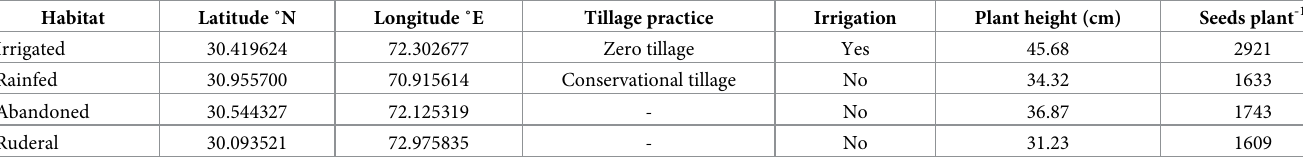
Table 1. Background information on the seed collection sites and some plant traits. Habitat Latitude ˚N